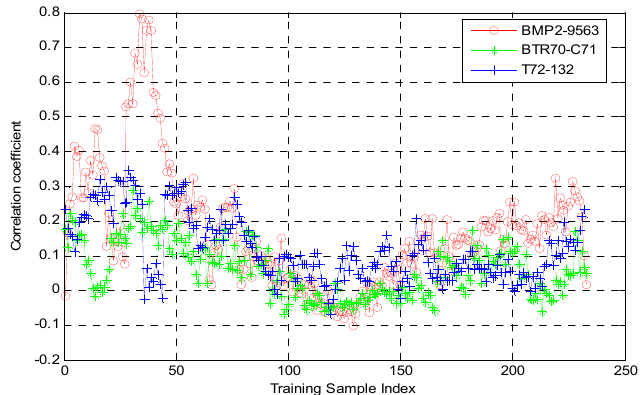
Figure 4. Correlation coefficient curve between BMP2-9563 testing sample (depression angle 15°, aspect angle 48.49°) and all training samples of targets BMP2-9563, BTR70-C71, and T72-132. Sensors 2016 , 16 , 1413